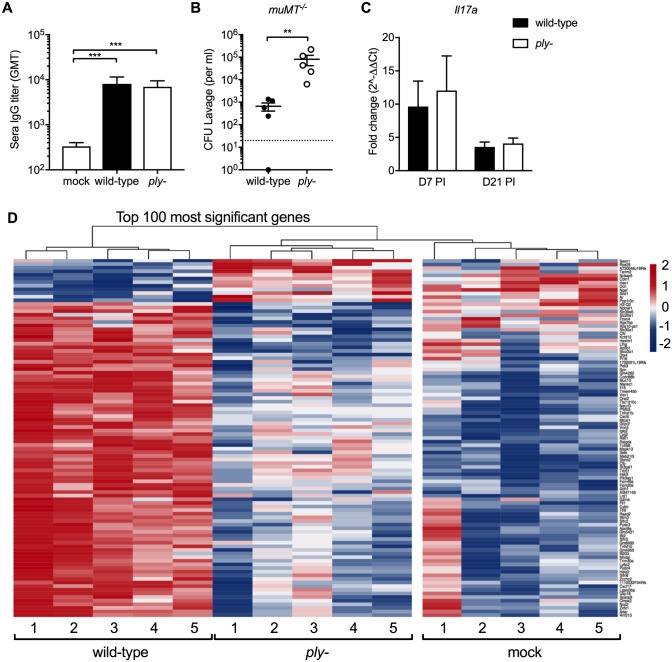
Host responses involved in pneumolysin-mediated clearance.Pups aged 4 days were infected with serotype 23F wild-type or ply-. (A) Sera IgG titers as determined by whole cell ELISA at 9 weeks post-challenge compared to age-controlled uncolonized (mock) mice. (B) Pneumococcal colonization density assessed in muMT-/- mice at 9 weeks post-challenge. (C) URT Il17a expression by qRT-PCR at day 7 (D7) and 21 (D21) post-infection. Fold-change was calculated from age-corrected mock-infected controls. Groups represent n = 5–11 animals with mean ±SEM. Dotted line represents the lower limit of detection. Significance is indicated by **, P < 0.01; ***, P < 0.001. (D) At day 21 after infection, five wild-type, ply-, and mock challenged pups received RLT lavages to obtain RNA for RNA-seq analysis. Heat-map of top 100 differentially regulated genes comparing wild-type to ply- demonstrating relative gene expression in log2 foldchange with increased expression in red and decreased expression in blue.